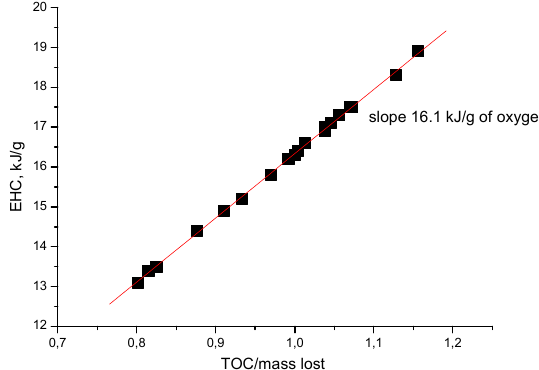
Figure 10. Universal correlation between EHC and total oxygen consumed related to unity of mass lost during burning (all parallel experiments involved).